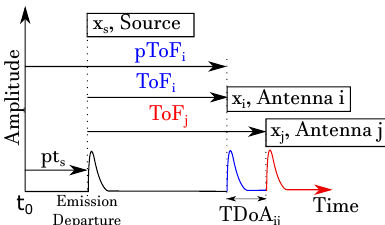
Figure 1. ToF, TDoA and pseudo-time of flight (pToF) representation for an emitting source x s and arbitrary receivers, e.g., sensors i and j